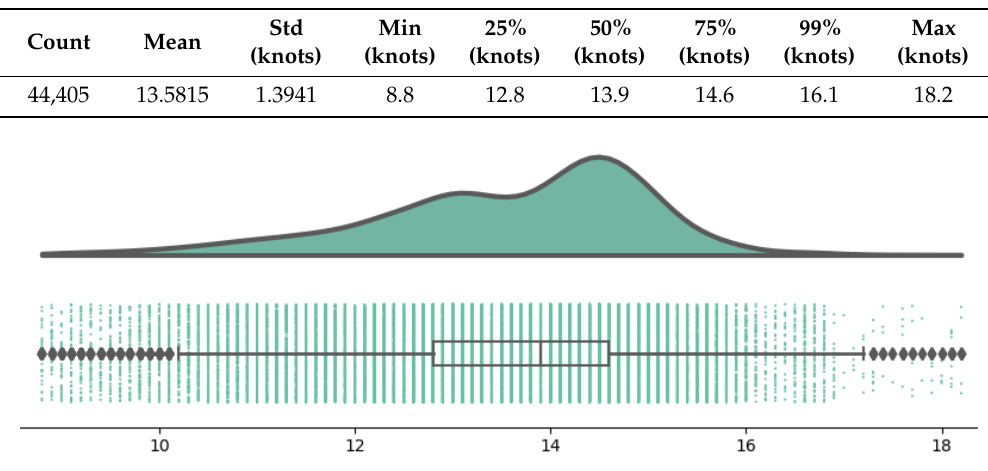
Table 1. Statistical characteristics of SOG.